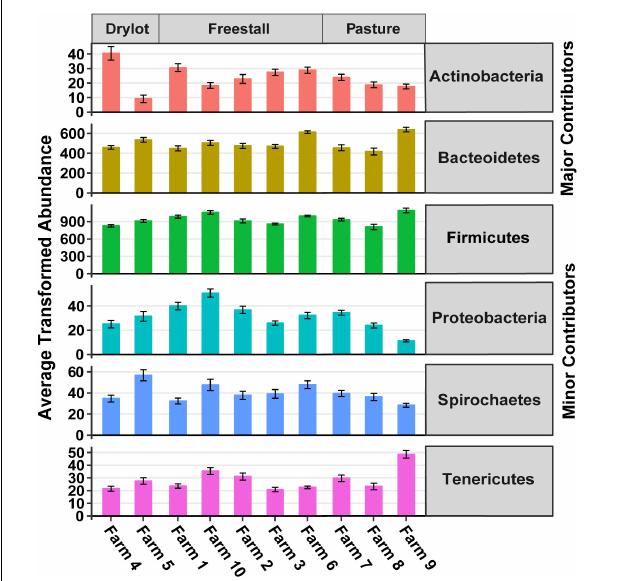
FIGURE 2 | Transformed average abundance ± SEM of major and minor contributing phyla across farms. Abundance of OTUs were transformed with the R package DESeq2 to account for differences in library sizes. Farm significantly affected transformed abundance of all phyla ( p < 0.001). Housing type affected transformed abundance of all major and minor contributing phyla except Spirochaetes and Bacteroidetes ( p ≤ 0.01). Determined by Kruskal–Wallis rank sum